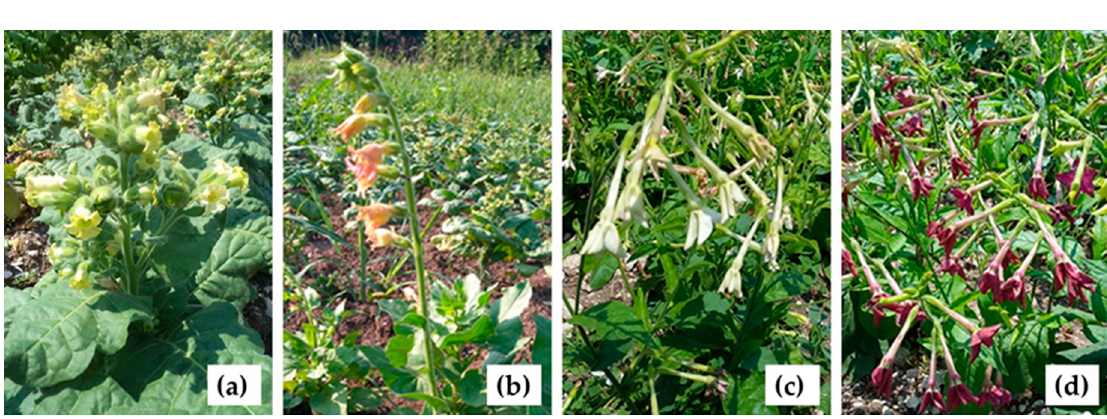
Figure 2. Flowers of Nicotiana plants at picking from the field: ( a ) N. rustica , ( b ) N. glutinosa , ( c ) N. alata genotype with white flowers, and ( d ) N. alata genotype with pink flowers (photos by authors).